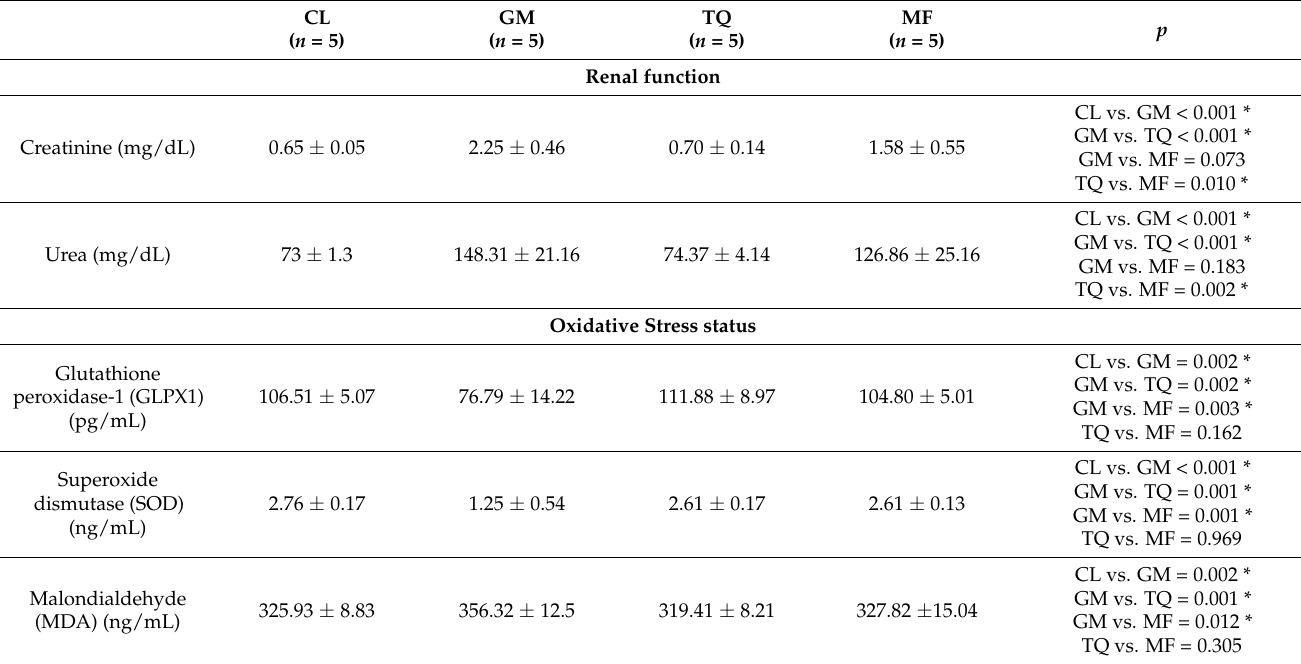
Table 1. Comparison of renal function and oxidative stress status between control (CL), gentamicin (GM), thymoquinone (TQ), and metformin (MF)-treated rats. Data expressed as Mean ±